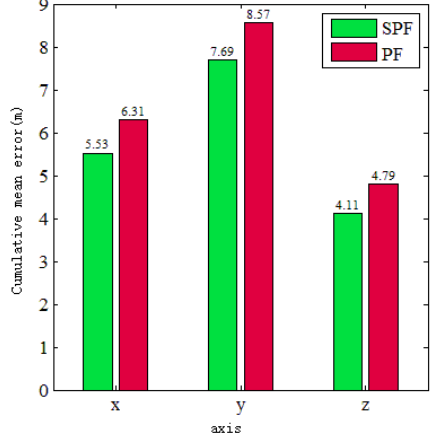
Figure 5. Localization error.